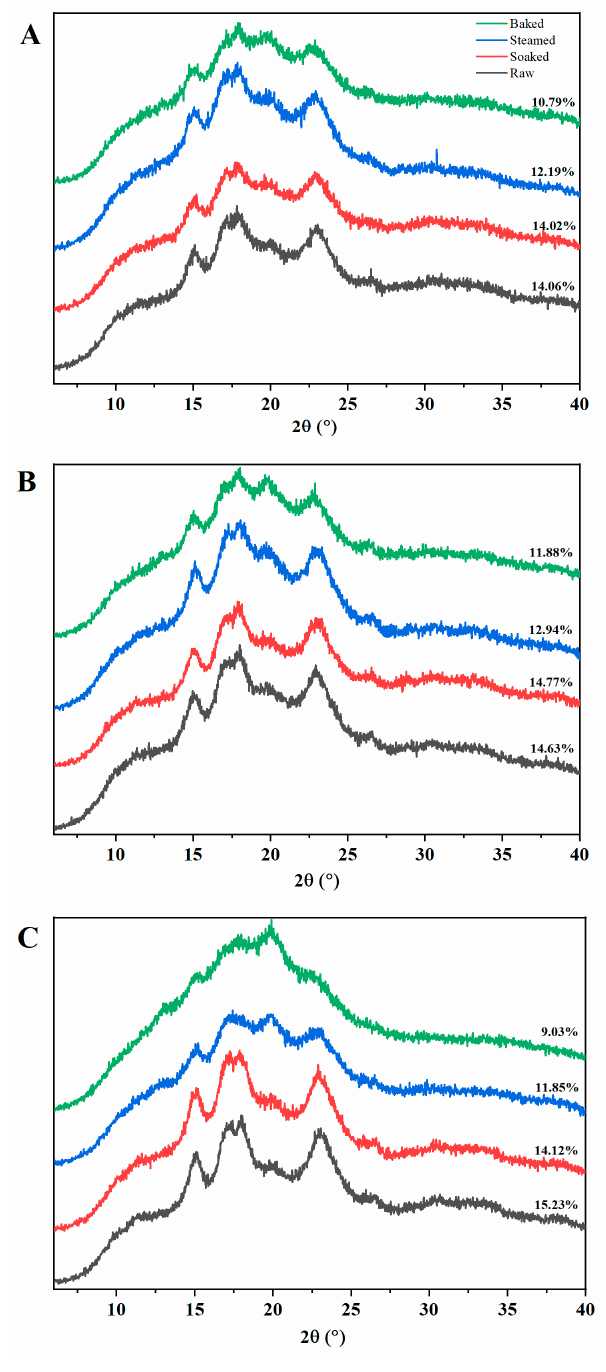
Figure 3. XRD patterns of raw and different processed starch from three cultivars of millet ( A – C ) represents M1, M2, M3, respectively).